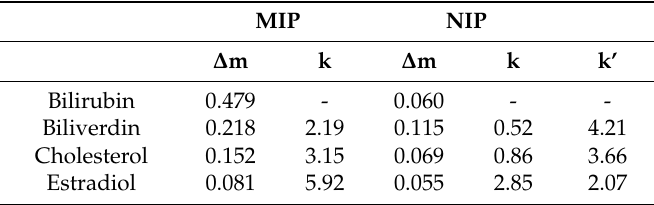
Table 3. Selectivity coefficients for the bilirubin-imprinted QCM